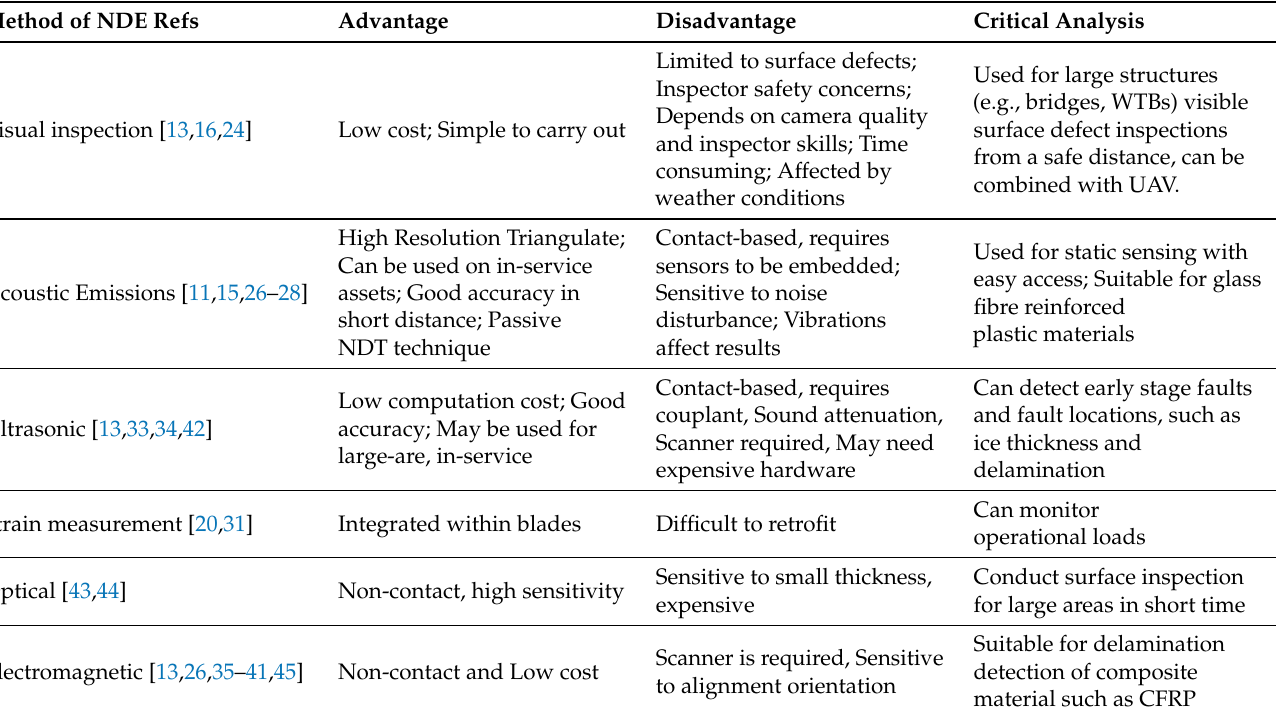
Table 1. Summary of NDE methods on WTBs with their advantages and